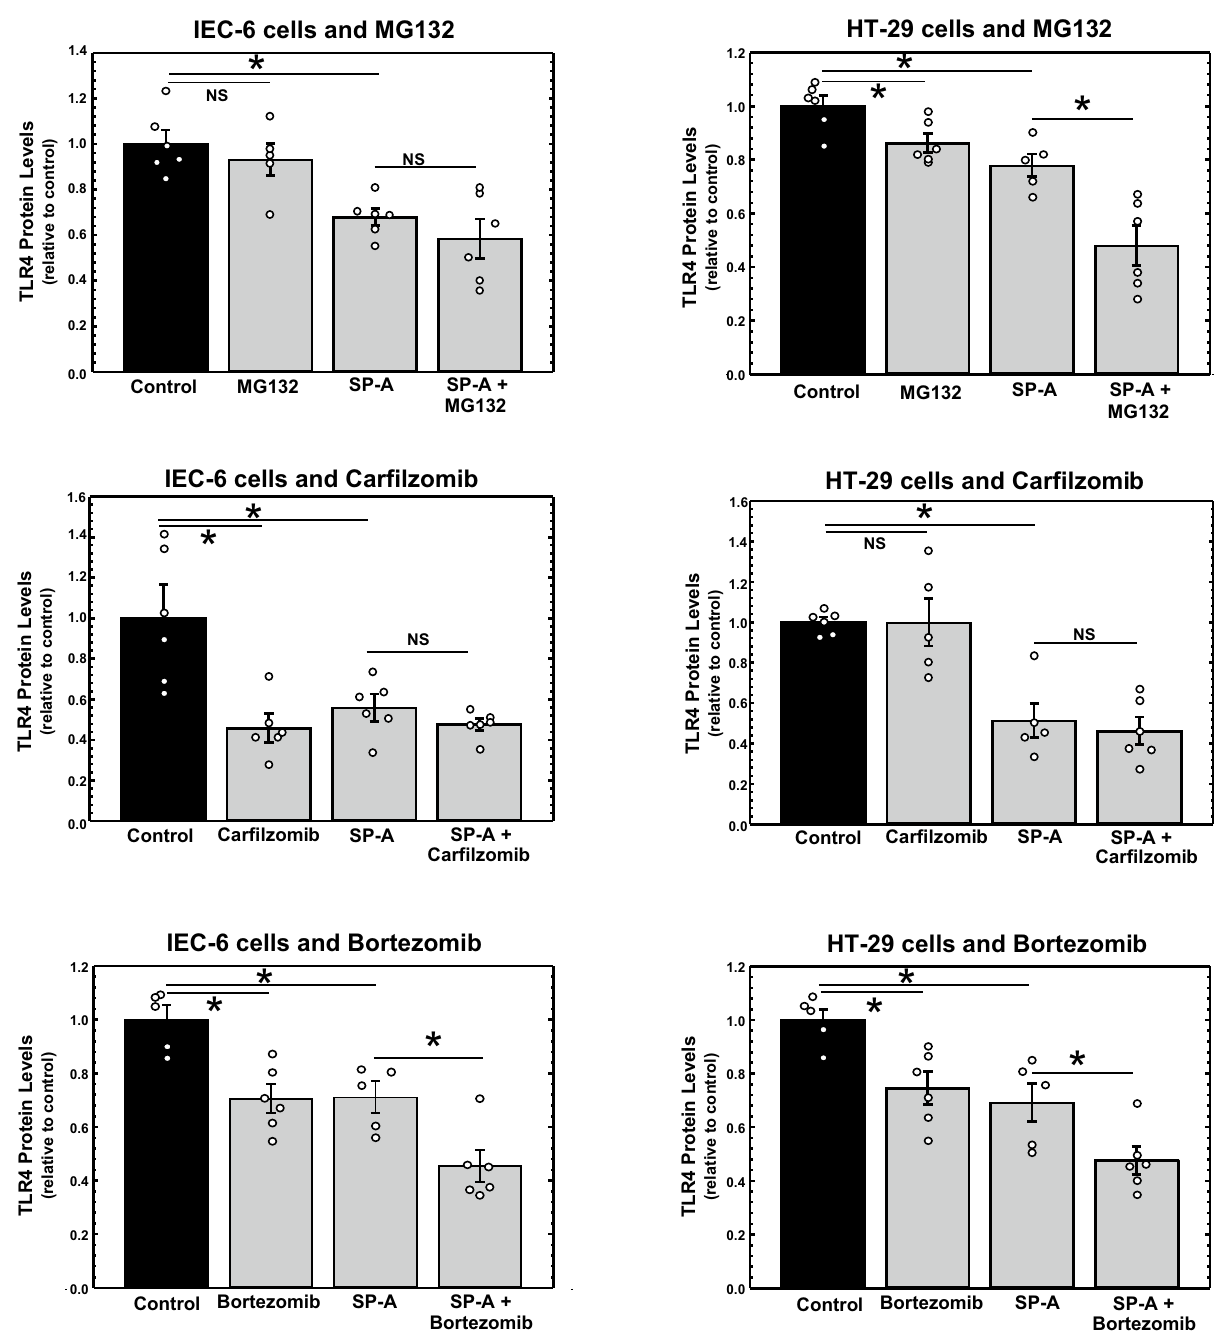
Figure 6. Impact of proteasome inhibitors on TLR4 protein levels in IEC-6 and HT-29 cells incubated in the absence or presence of SP-A. Cells were incubated in the absence or presence of purified human SP-A for 6 h. During the last hour of incubation, MG-132 (20 µM), carfilzomib (20 µM) or bortezomib (20 µM) was added. Shown are the results of 2 determinations, n = 6 from 2 assays. Figure created using SigmaPlot, ver 14, www.systa tsoft